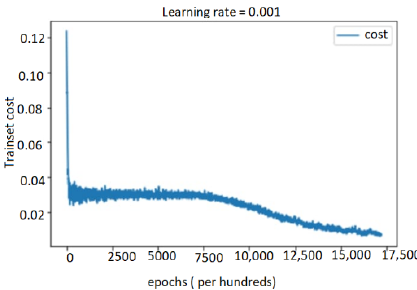
Figure 8. Training cost versus epochs for audio modality.